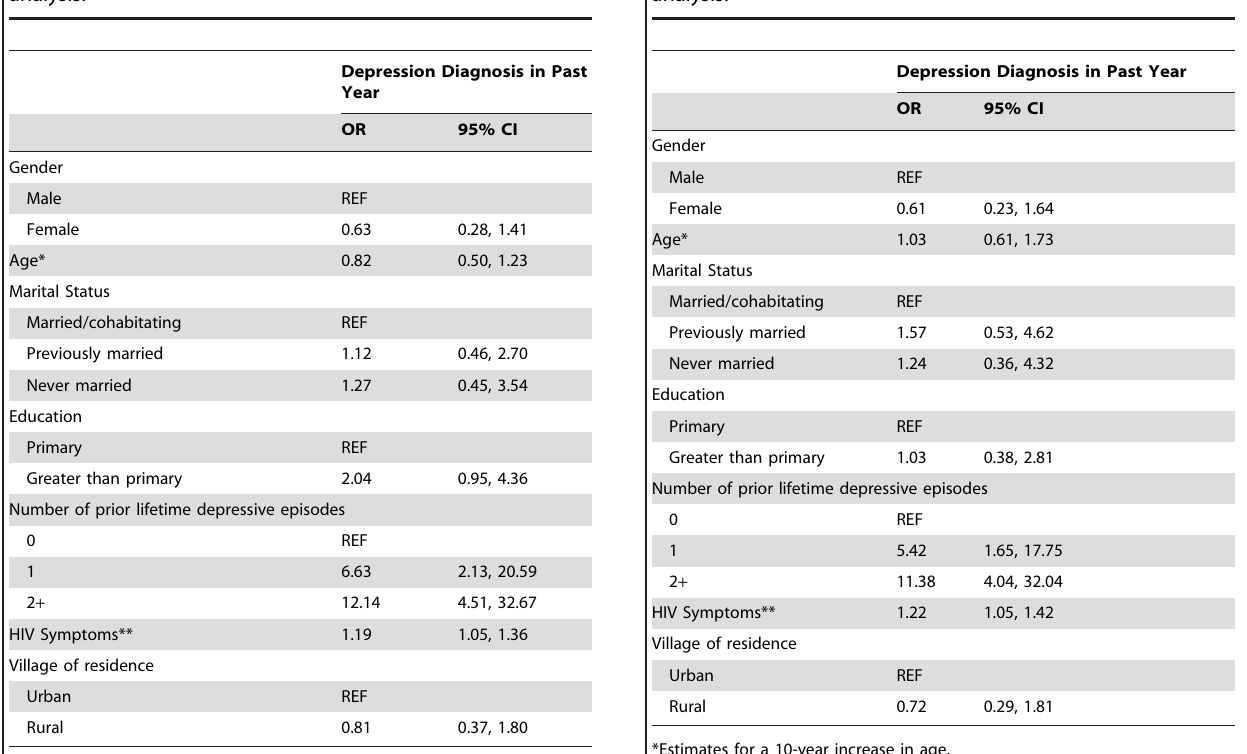
Table 5. Correlates of depression diagnosis – bivariable analysis.